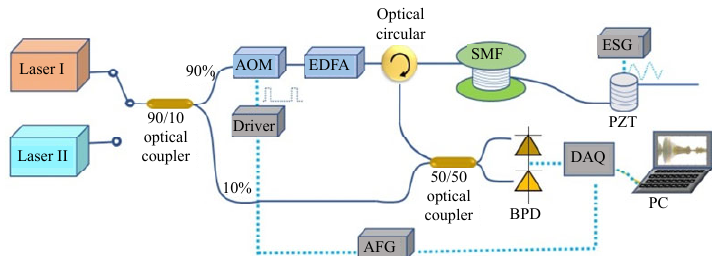
Fig. 1 Experimental setup of φ -OTDR: acoustic-optic modulator (AOM), arbitrary function generator (AFG), erbium-doped fiber amplifier (EDFA), single-mode fiber (SMF), electrical signal generator (ESG), piezo transducer (PZT), balanced photo-detector (BPD), data acquisition (DAQ), and personal computer (PC).